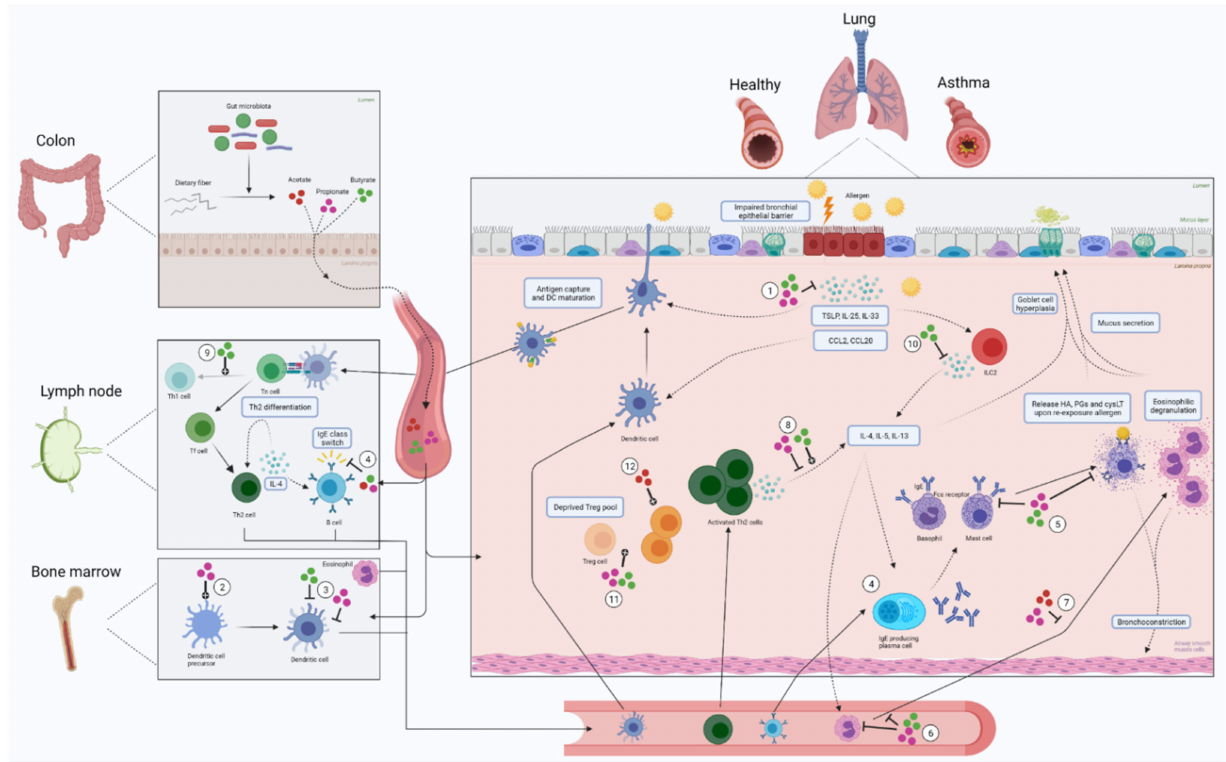
Figure 3. Effects of SCFAs on the immune response in allergic asthma. Upon allergen exposure the airway epithelial barrier is damaged and activated, leading to type 2 driving mediator release and DC activation. These DC capture allergens and migrate to the mediastinal lymph nodes, where allergen presentation by DCs stimulates Th2 differentiation. Th2 cells instruct allergen-specific B cells to produce IgE (isotype switching). Th2 and plasma cells migrate to the mucosal tissue in the bronchi. Activated Th2, ILC2 and allergen-IgE stimulated mast cells induce eosinophil infiltration